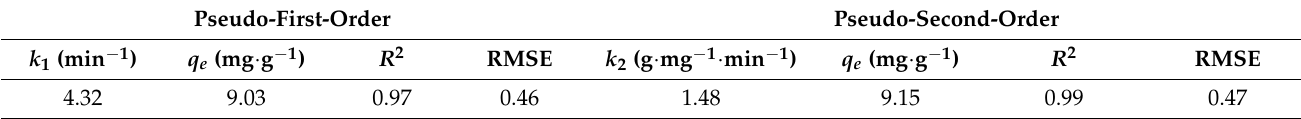
Table 2. Parameters of the kinetic models fitted to the experimental data.